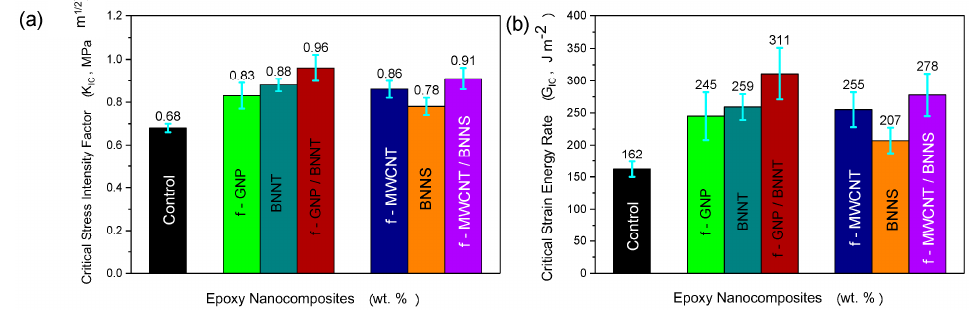
Figure 7. ( a ) Critical stress intensity factor, K IC , and ( b ) critical strain energy release rate, G IC , for the